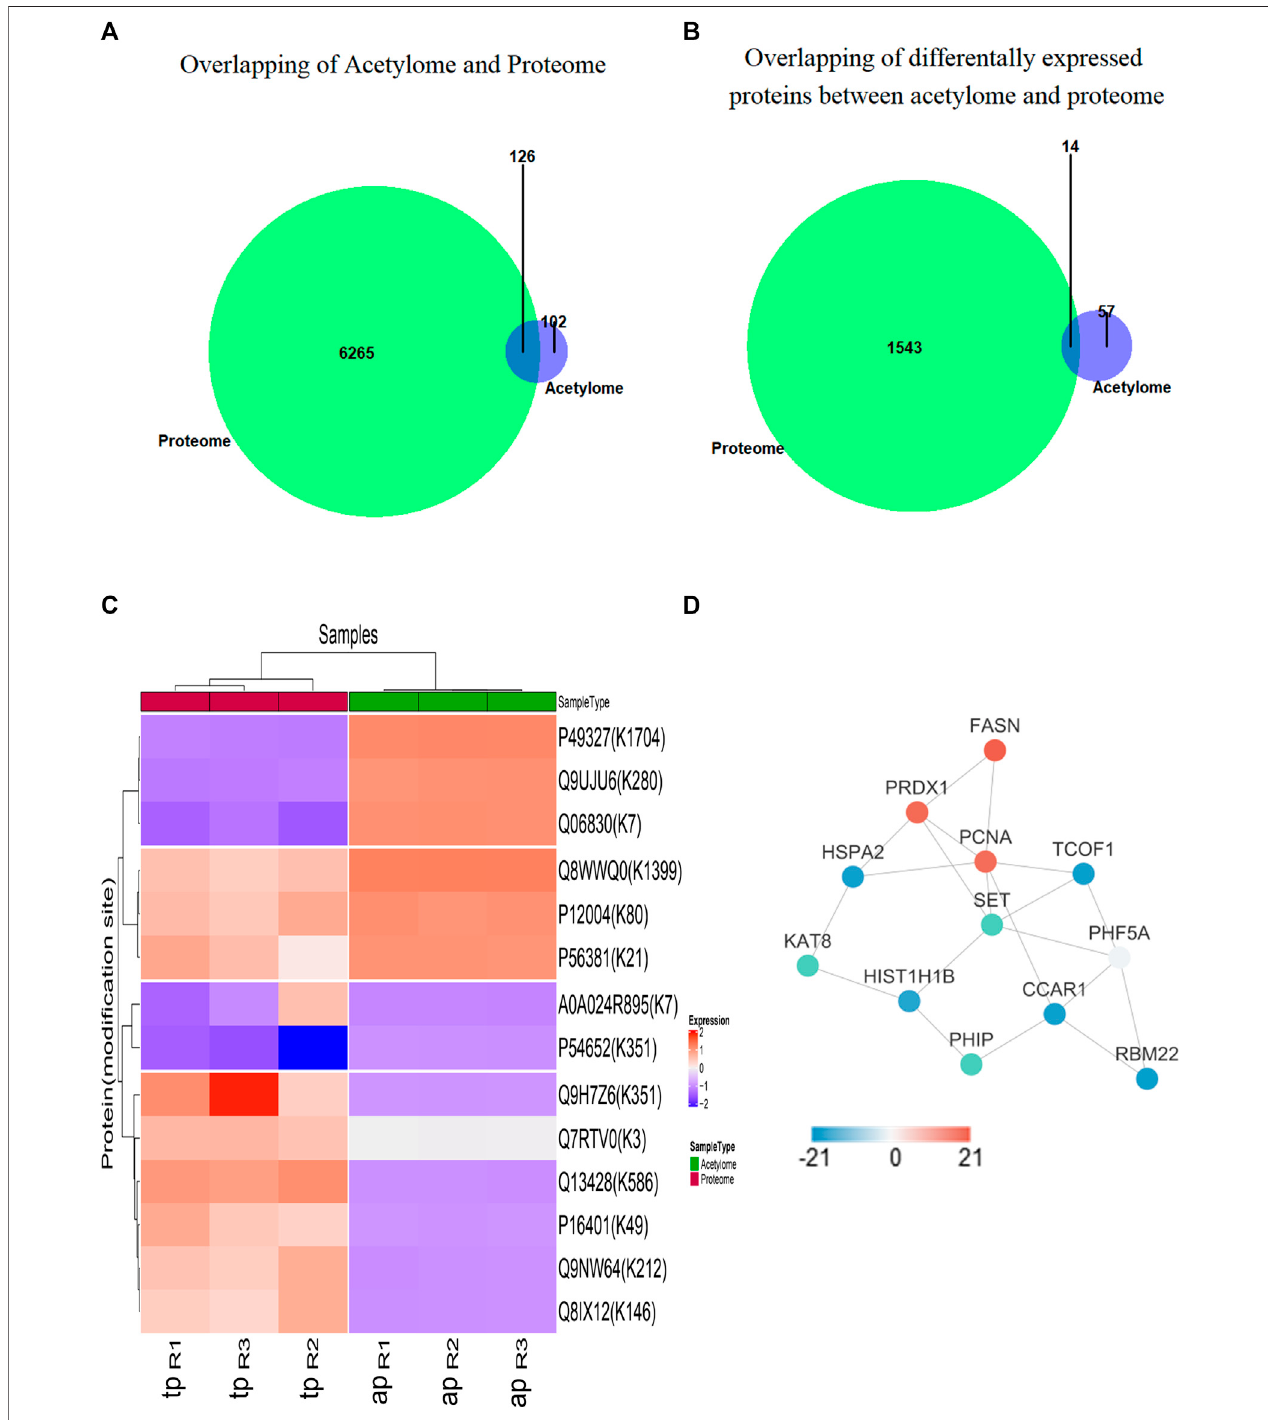
FIGURE 4 | Functional analysis between proteome and acetylome. (A) Overlap of total proteins between acetylome and proteome. (B) Overlap of differentially expressed proteins between acetylome and proteome. (C) Heatmap diagram of a two-way hierarchical clustering. Diagram consists of the 14 most differentially expressed proteins in the global proteome and acetylome. The red and blue colors indicate the expression level of proteins in terms of normalized ratio. Upper color labeling shows total proteome samples in red and acetylome in green. The distance of hierarchical clustering was measured using the Euclidean method. (D) Protein – protein interaction network of differentially expressed proteins between acetylome and proteome.